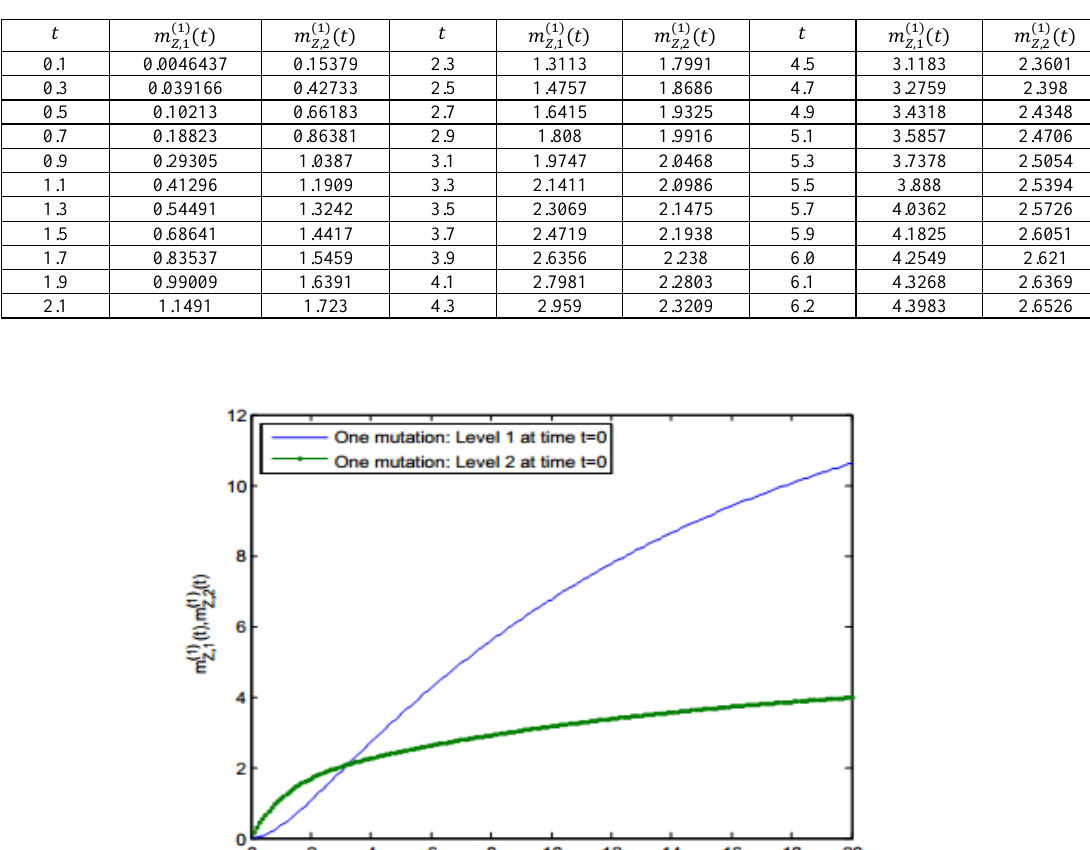
Table 5. One mutation: comparison of growth of malignant cells